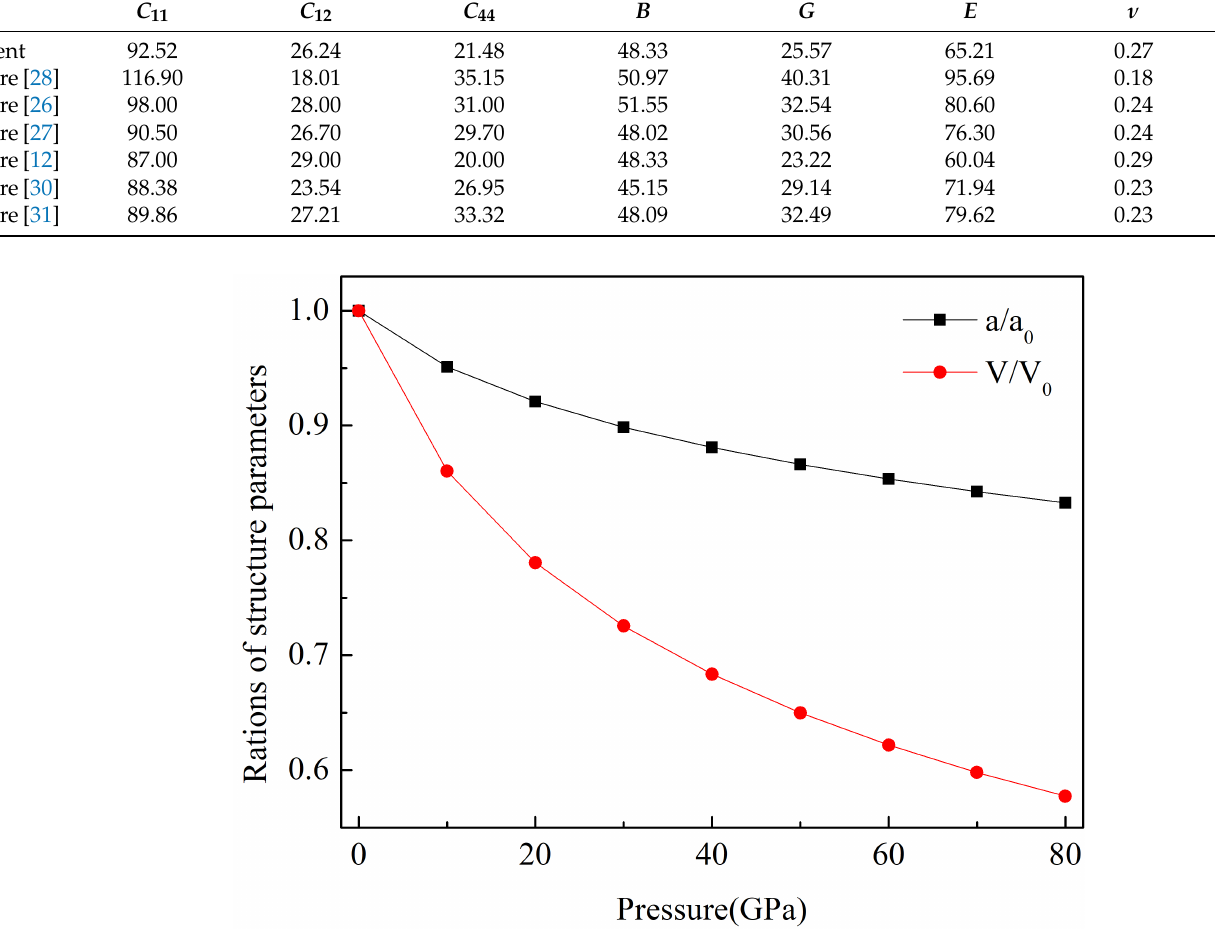
Figure 3. Based on the applied pressure, the plots depict the variation in a / a 0 and V / V 0 for the β -Mg 17 Al 12